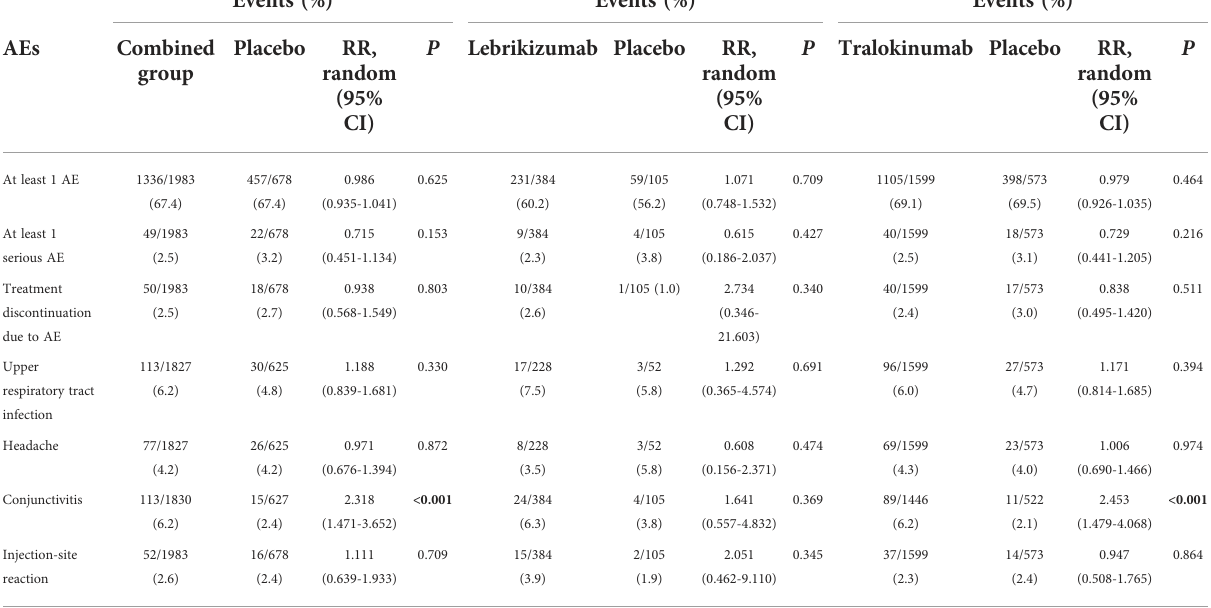
TABLE 2 AEs associated with lebrikizumab and